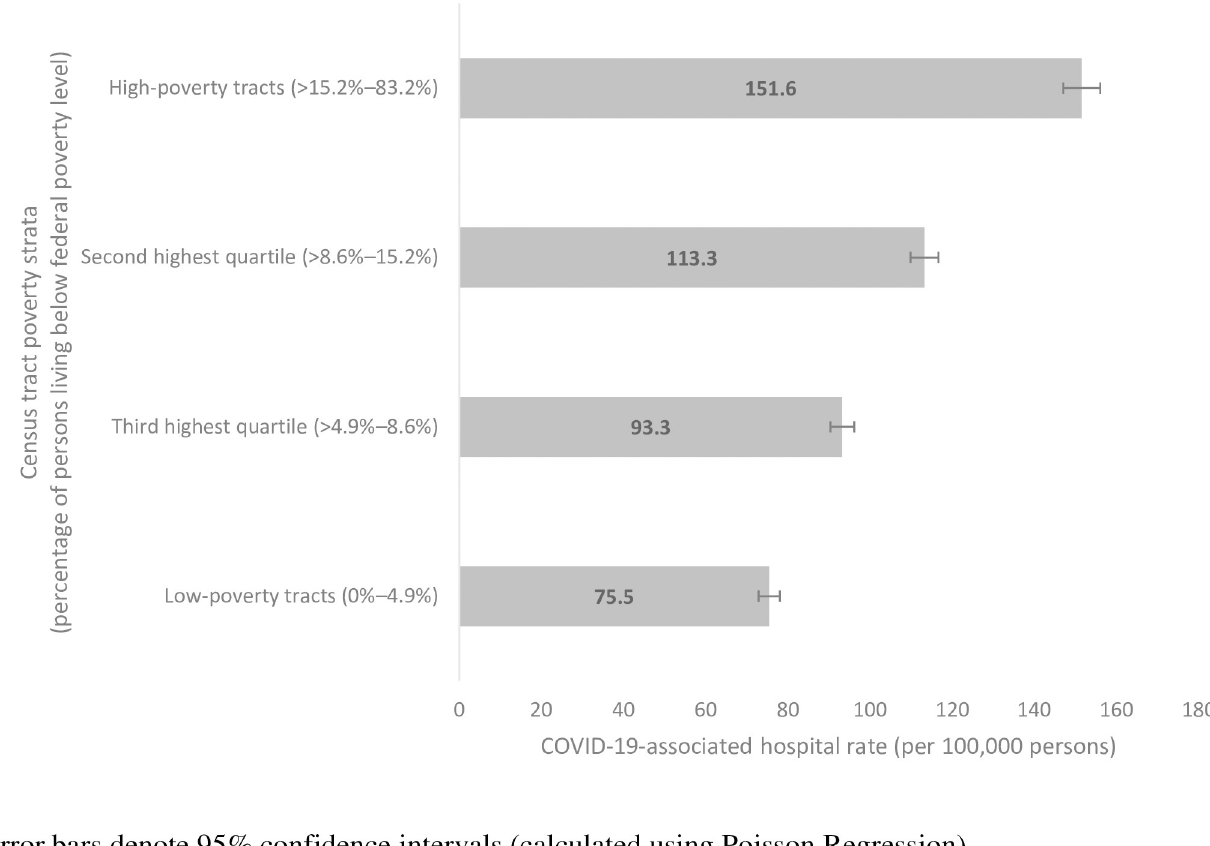
Fig 1. Age-adjusted COVID-19-associated hospitalization rates by census tract-level poverty strata (quartile)—COVID-NET catchment areas in 14 states, March–April 2020.